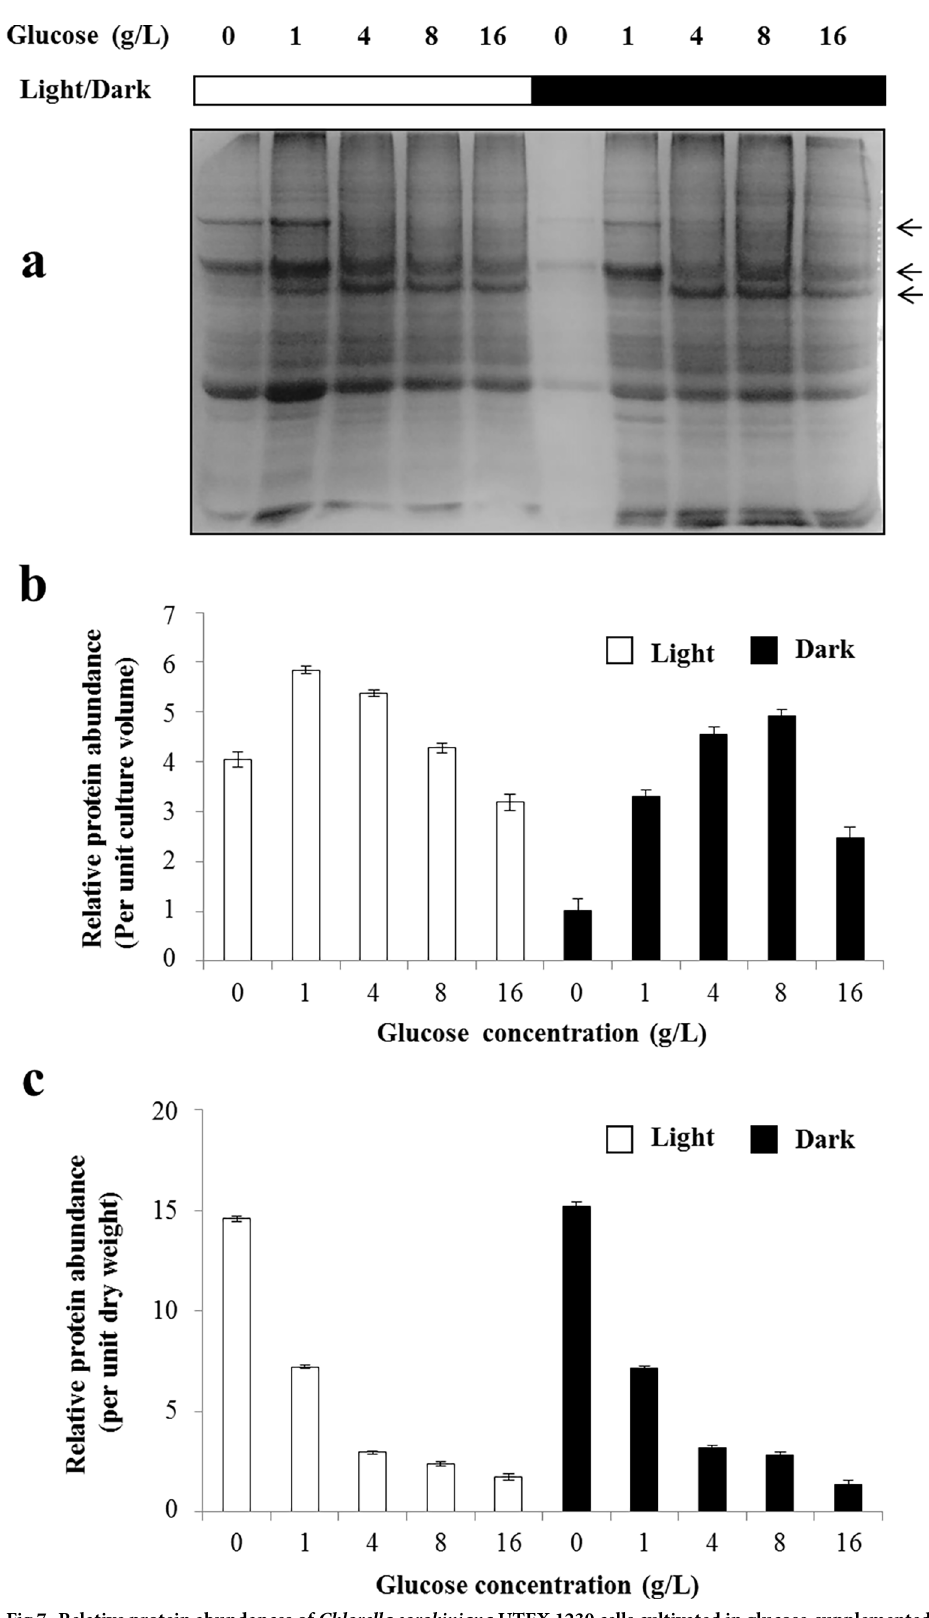
Fig 7. Relative protein abundances of Chlorella sorokiniana UTEX 1230 cells cultivated in glucose-supplemented medium. C . sorokiniana UTEX 1230 cells cultured in glucose-supplemented medium were harvested. Extracted total